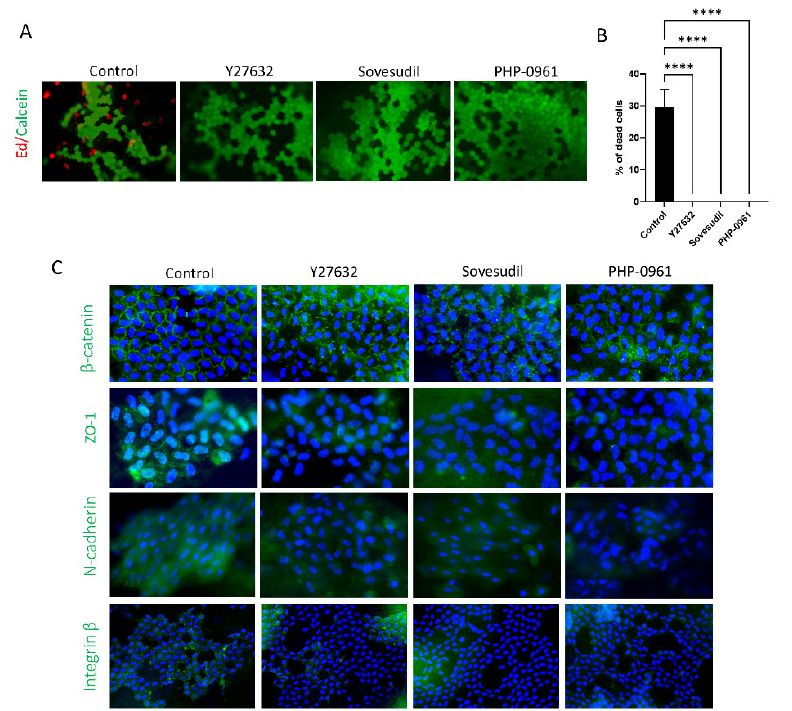
Figure 5. Effect of sovesudil on protection and cell adhesion of corneal endothelium in porcine ex vivo study. ( A , B ) Live/dead cell assay. Red is dead, and green indicates live cells. ( C ) Immunofluorescence staining of β-catenin, ZO1, N-cadherin and integrin-β1. **** p < 0.0001. To evaluate the effect of Y-27632, sovesudil and PHP-0961 on wound healing of corneal endothelium of ex vivo porcine cornea, Alizarin S red staining was performed. Alizarin S red staining showed faster wound healing in porcine corneas with Y-27632, sovesudil, and PHP-0961 (Figure 6A,B). SOX2 was immuno-stained as the proliferation marker. SOX2-positive cells were higher in Y-27632, sovesudil and PHP-0961 (Figure 6C,D).